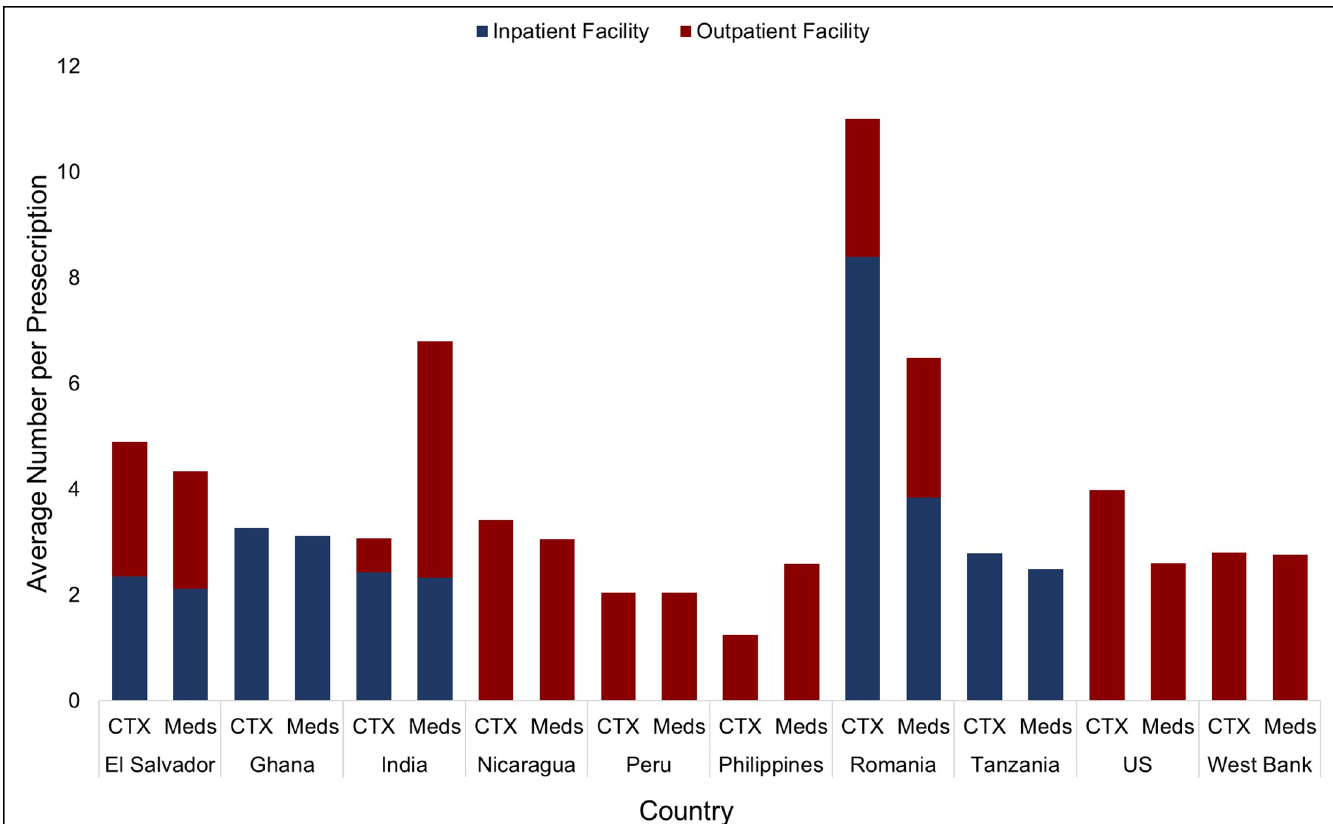
Fig 3. Estimated number medications and course treatments per prescription by level of care. � CTX = Average number of course treatments per prescription �� Meds = Average number of medications per